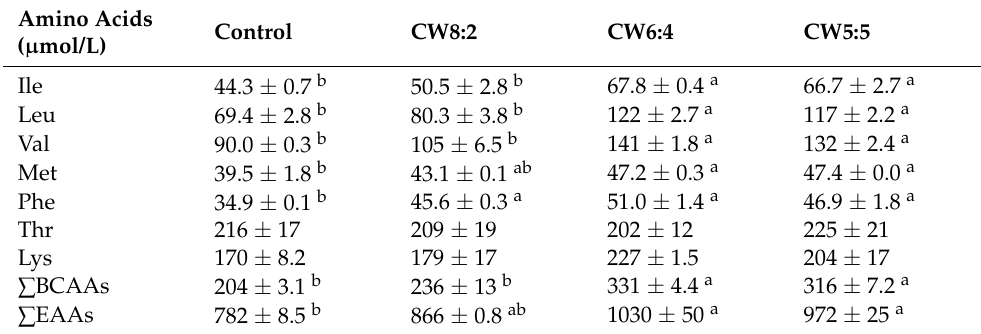
Table 3. Plasma essential amino acids concentrations 60 min after administration of milk with adjusted casein to whey proteins ratios ( n =